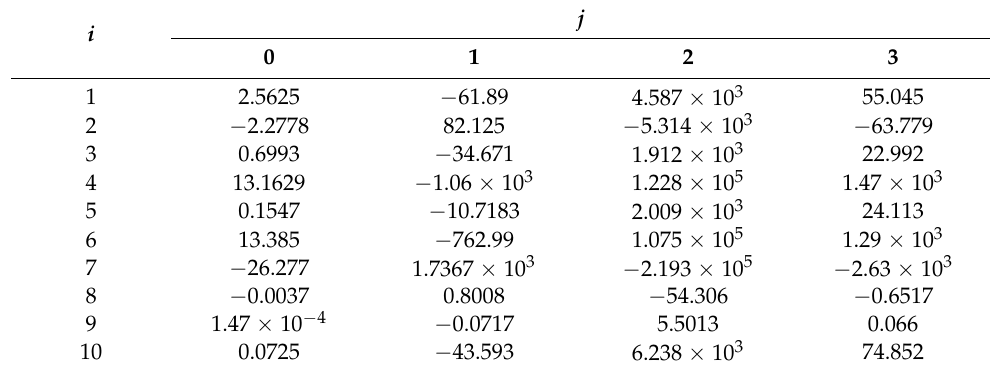
The results of β i , j were obtained by using the LS algorithm, as shown in Table 4. Table 4. Results for the parameters β m , i in (30).